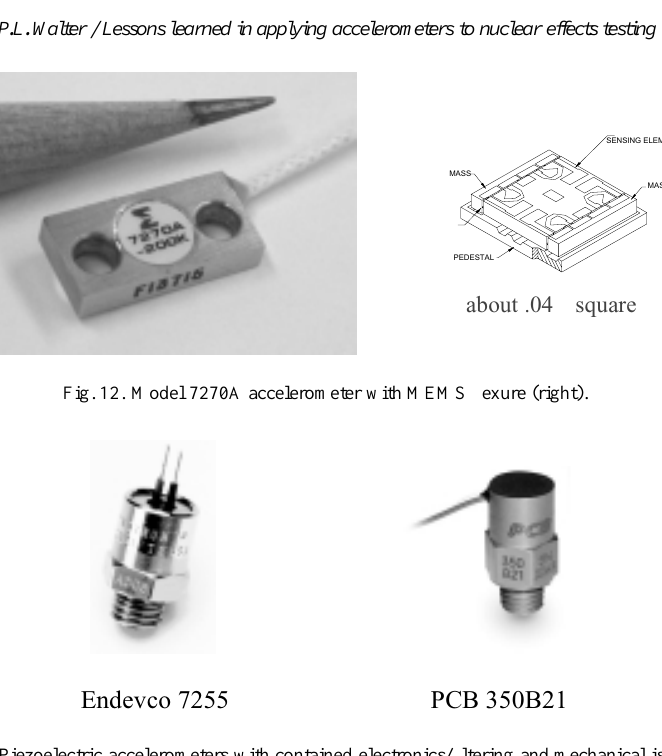
Fig. 13. Piezoelectric accelerometers with contained electronics/filtering and mechanical